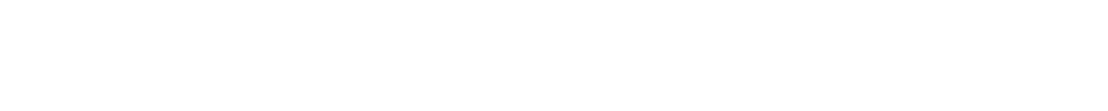
FIGURE 2 |Target detection times of Experiment 1, broken down by Cueing (cued vs. uncued location), CueValence (threatening vs. neutral), and Stimulus OnsetAsynchrony (SOA) . Left panel: patient group; right panel: control